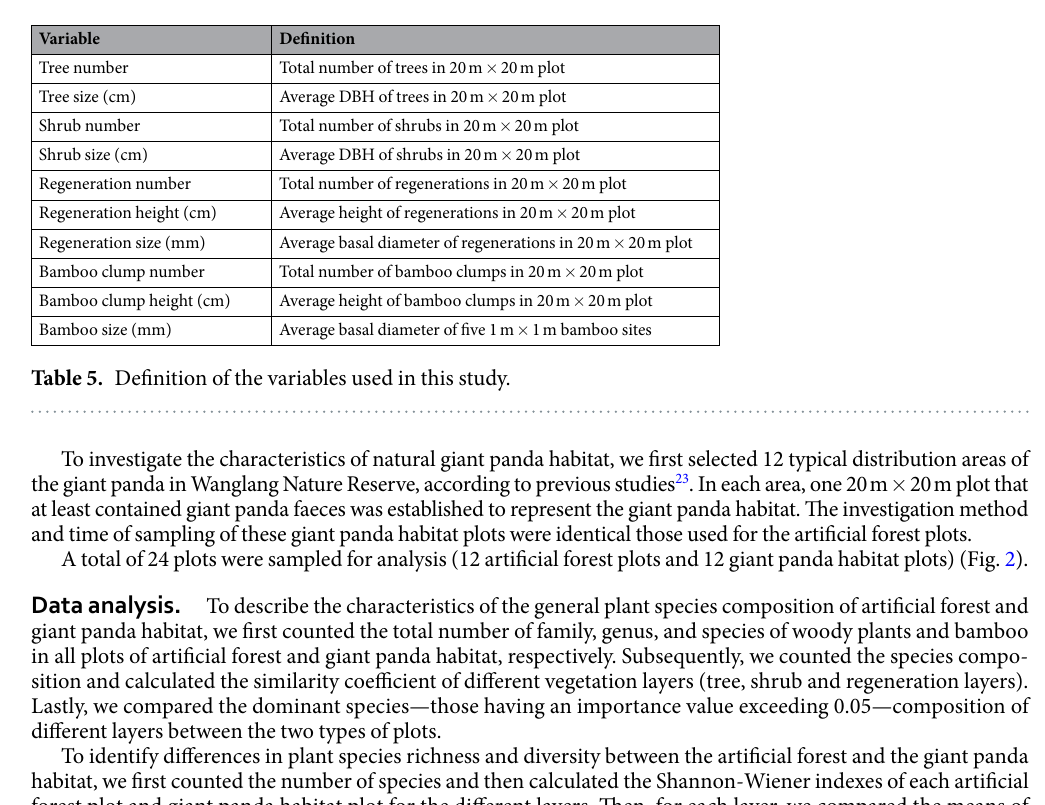
Figure 2. Distribution of plots in this study. This figure was generated by ArcGIS 10.2.